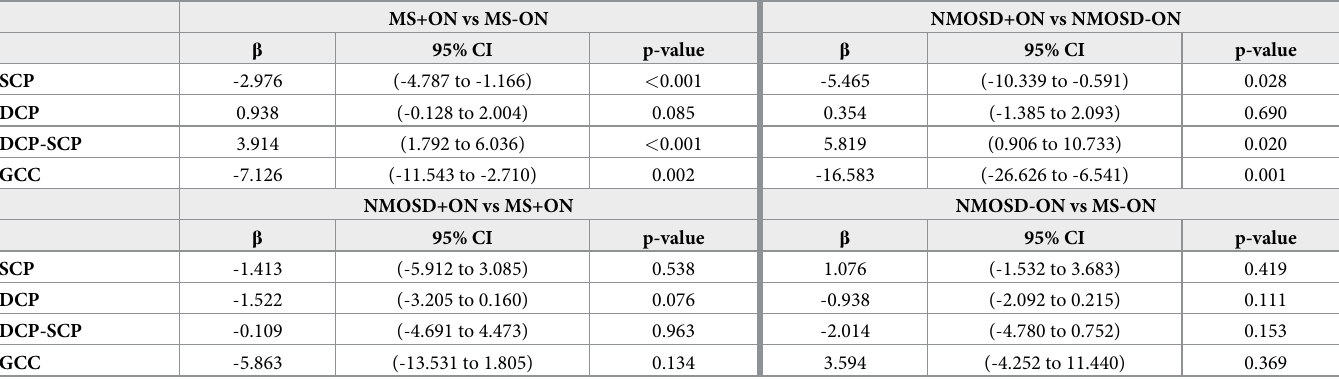
Table 4. Comparison of vessel density and ganglion cell complex thickness between selected groups.